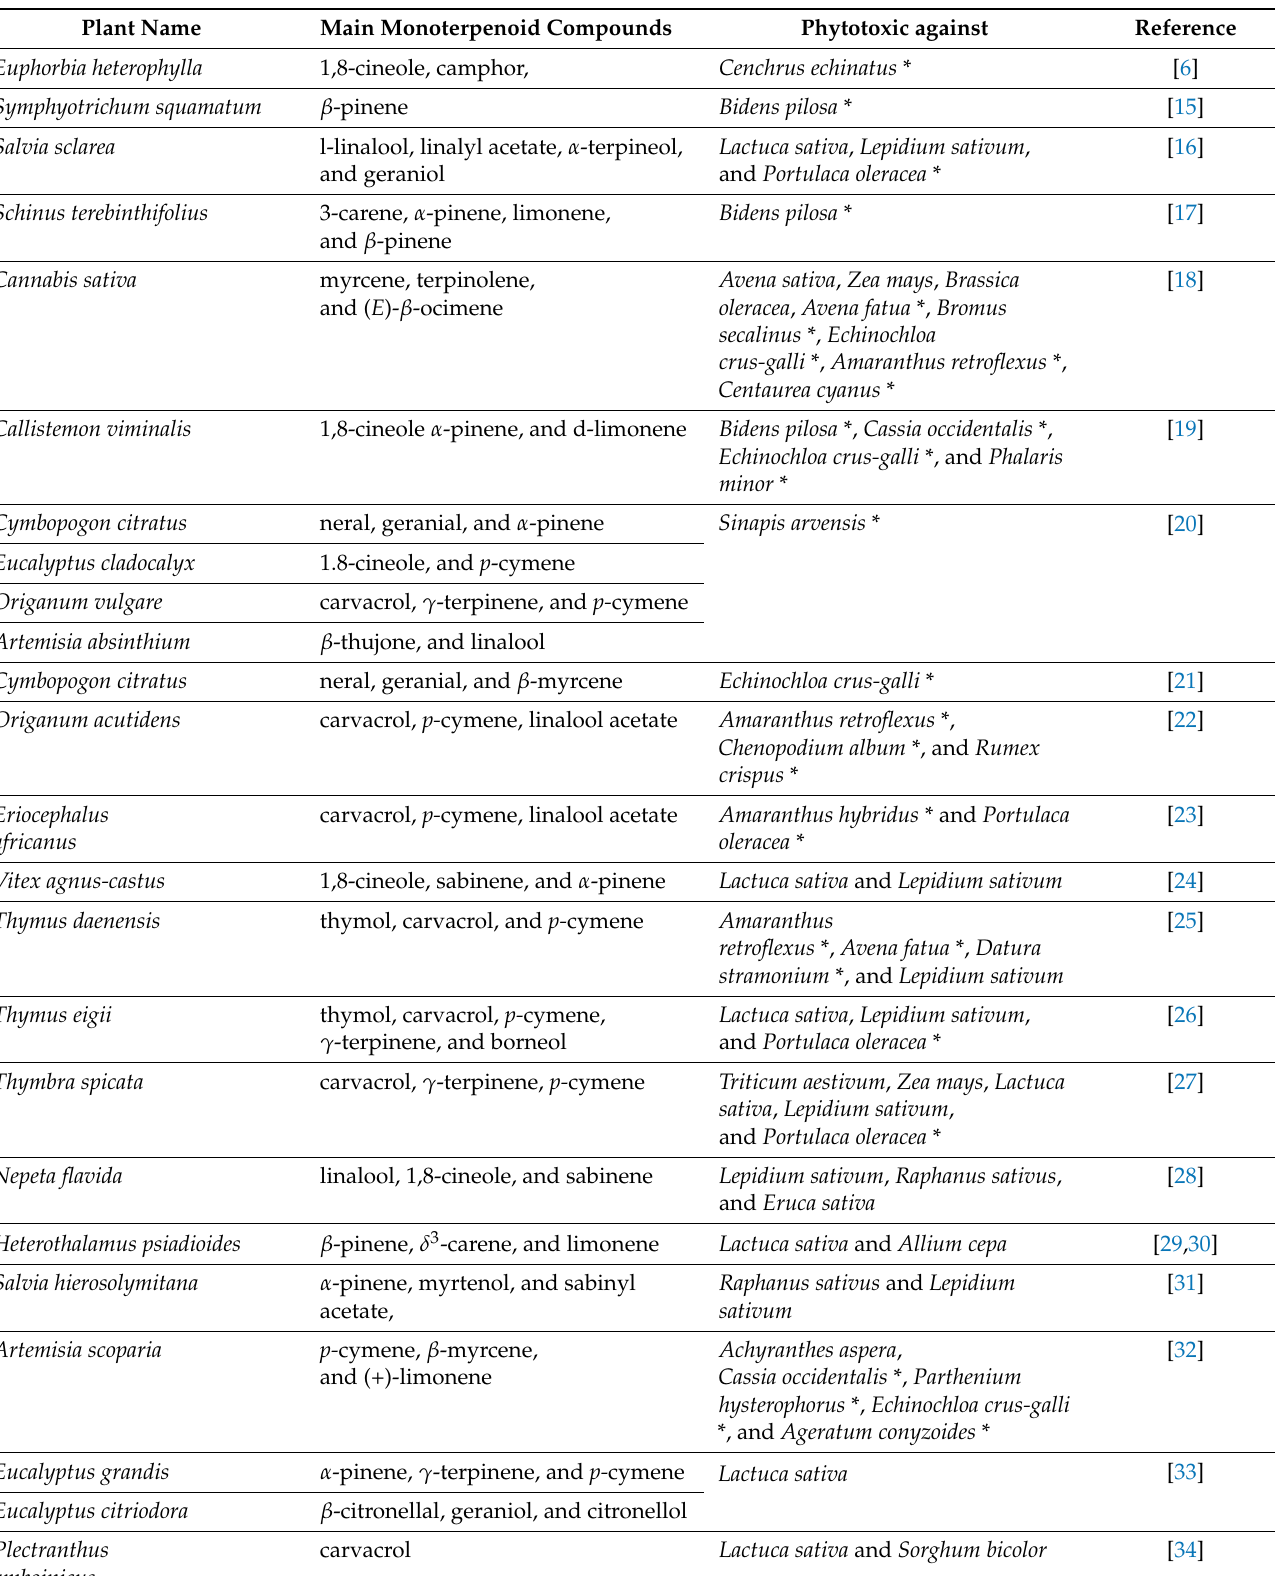
Table 1. Monoterpene-rich EOs derived from various reported plants with significant allelopathic